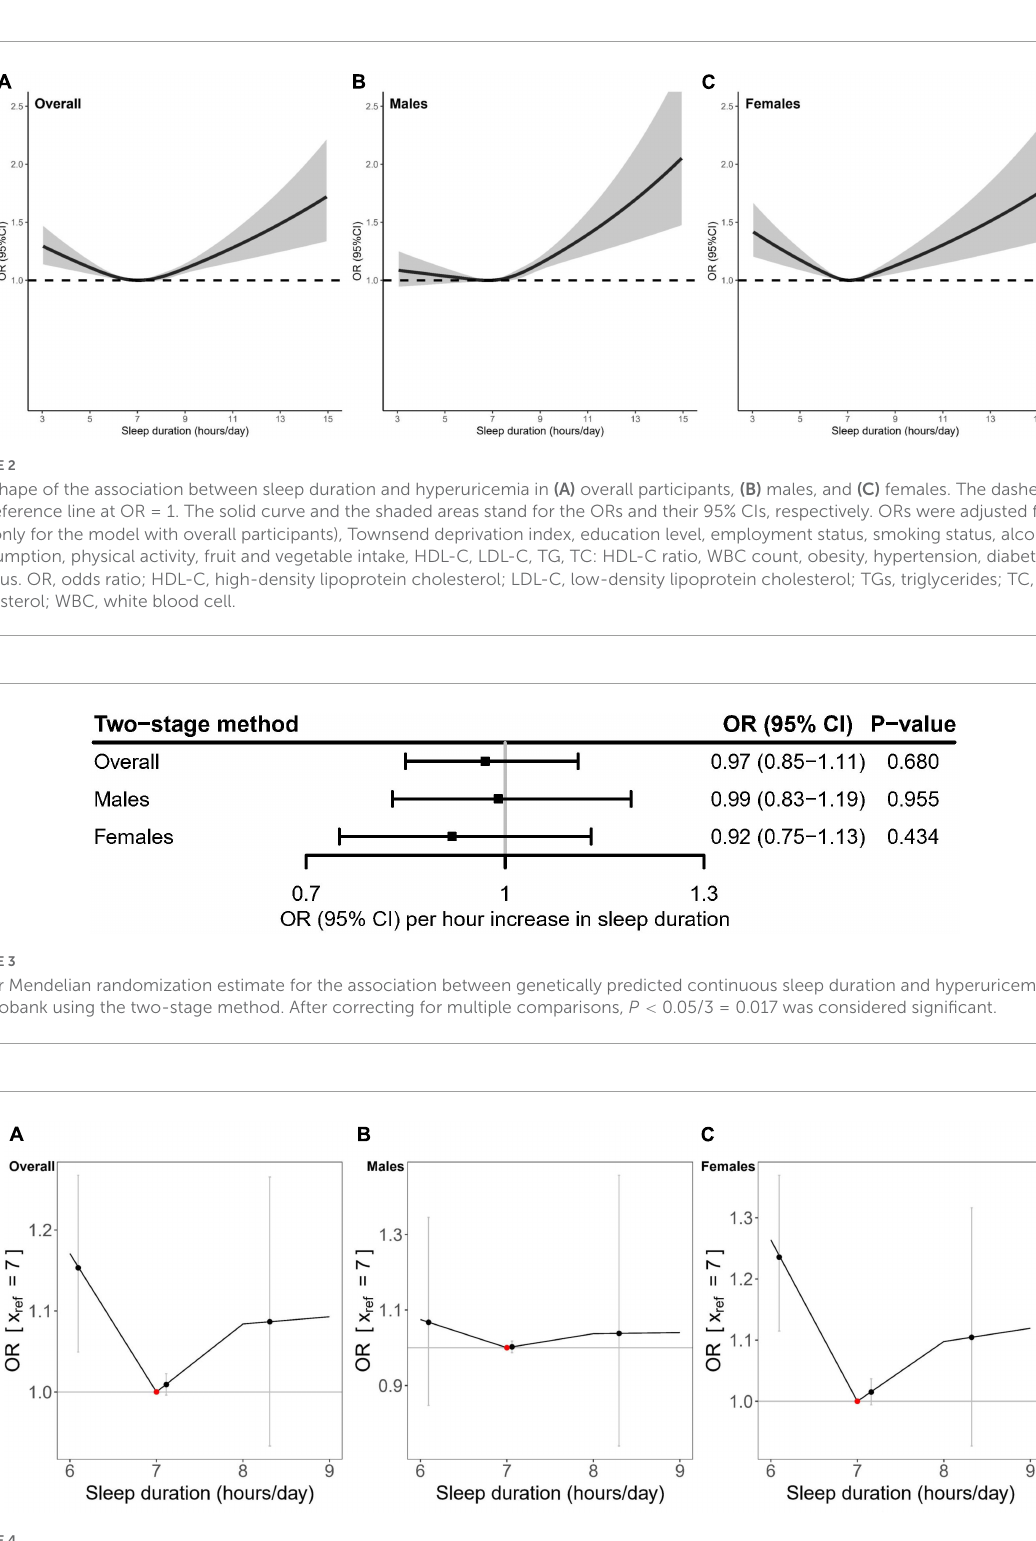
FIGURE4 Non-linear Mendelian randomization results between genetically predicted continuous sleep duration and hyperuricemia in (A) overall participants, (B) males, and (C) females. Localized average causal effects (LACE) for hyperuricemia were estimated using the piecewise linear method. Black dots (grey vertical lines) mean the LACE (95% CI) in each stratum; the red dot represents the reference point of sleep duration of 7